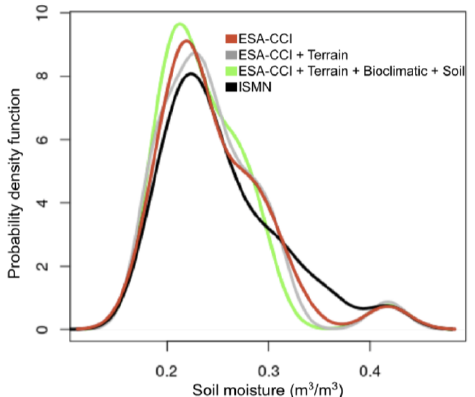
Figure 3. Statistical distribution of the ESA-CCI soil moisture dataset (red), the predictions of soil moisture using the k -KNN al- gorithm (gray and green), and the augmented ISMN dataset (black). The lines represent the values of each dataset at the locations of all existing datasets (locations reported in the augmented